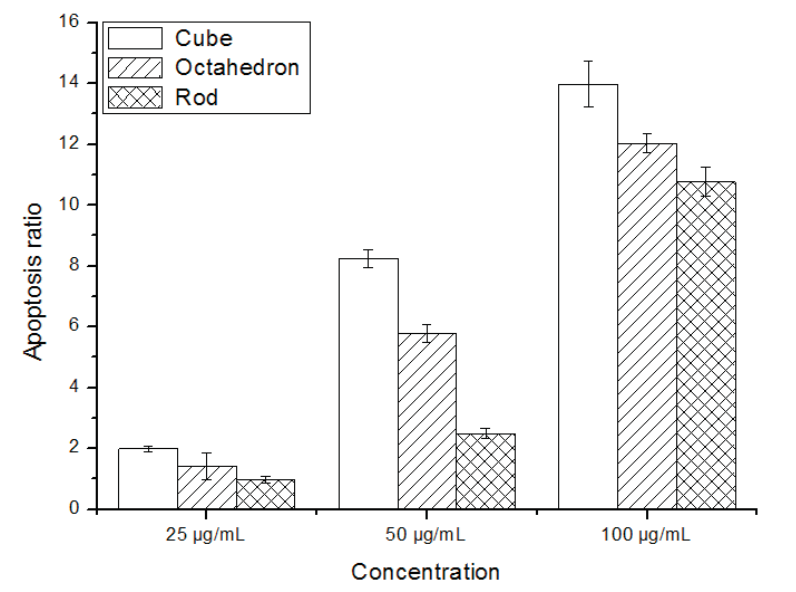
Figure 5. Percentage apoptosis of HepG2 cells after exposure to varying concentrations and types of nano-CeO 2 for 24